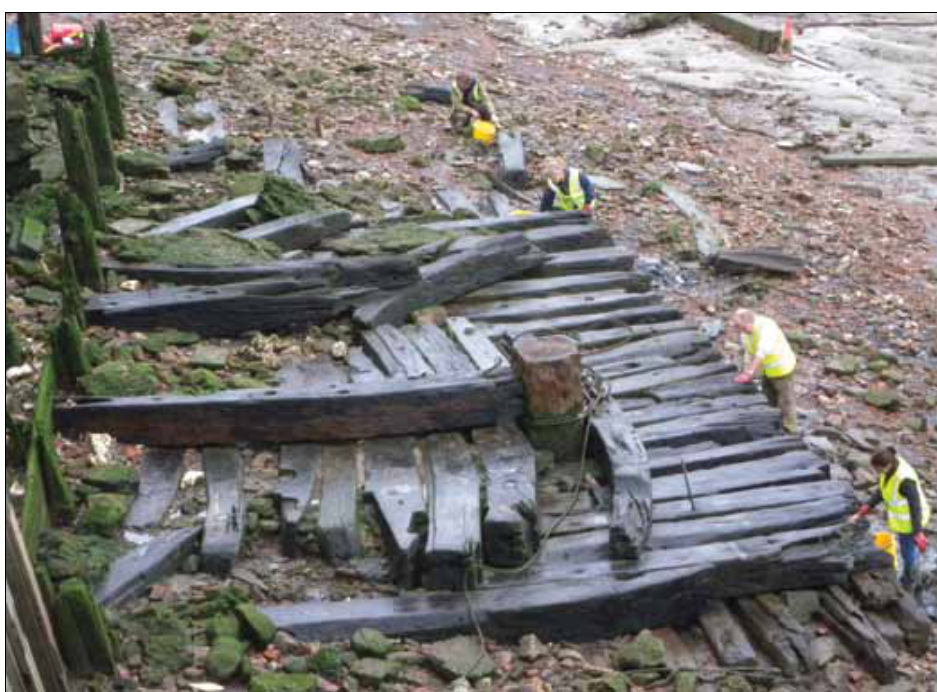
Fig. 5: Cleaning the working platform at Charlton (photo N.